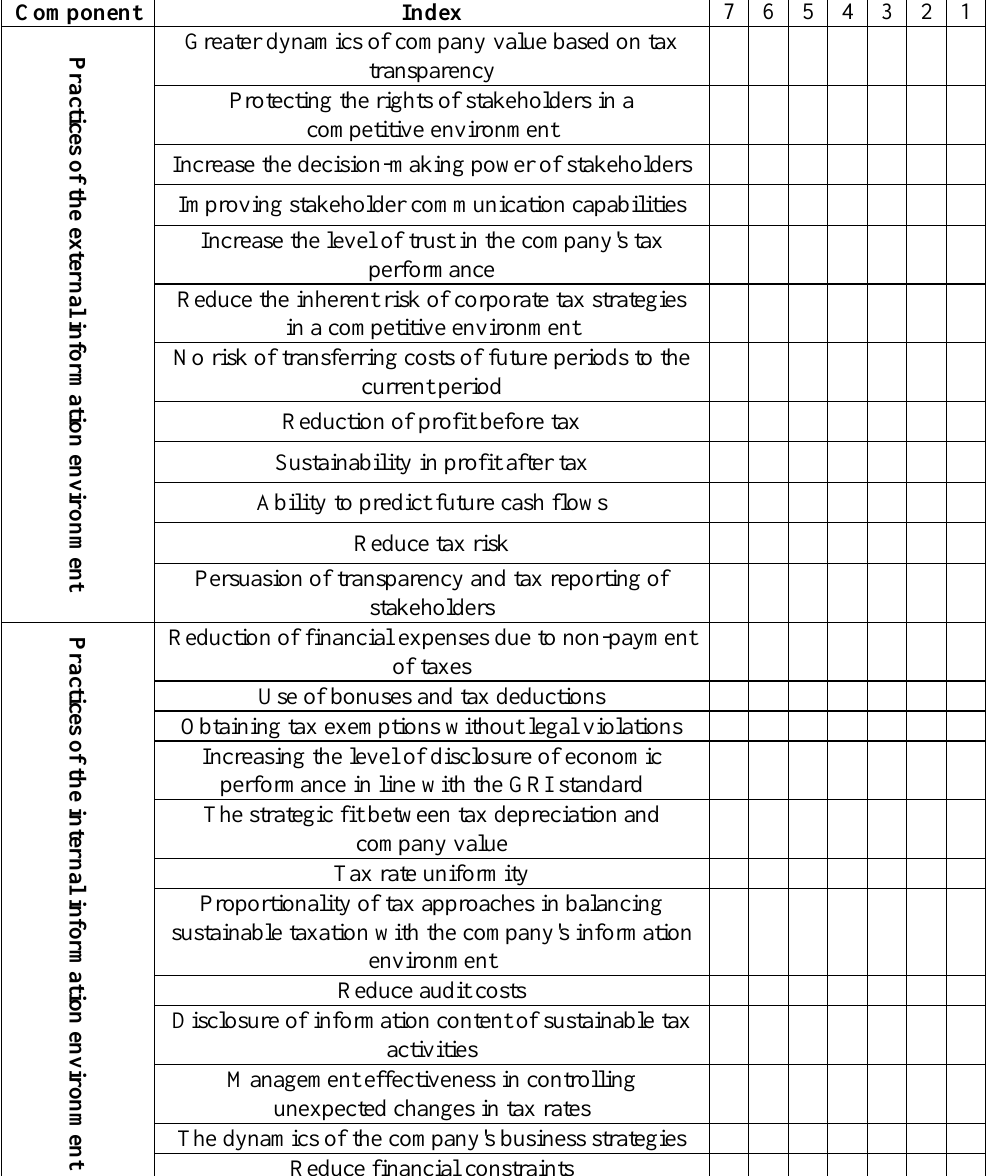
Table 3. The indices of tax consequences under corporate information environment conditions